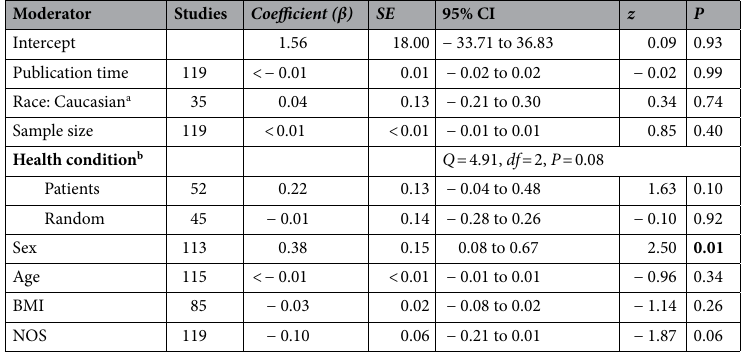
Table 2. Meta-regression analysis for relationship between R219K and HDLC under recessive model. Test of the model: Q M = 19.07, df = 9, P = 0.02; Goodness of fit test: Q G = 989.09, df = 72, P < 0.01. Bold indicates statistically significant ( P < 0.05). BMI, body mass index; NOS, Newcastle–Ottawa Scale assessment